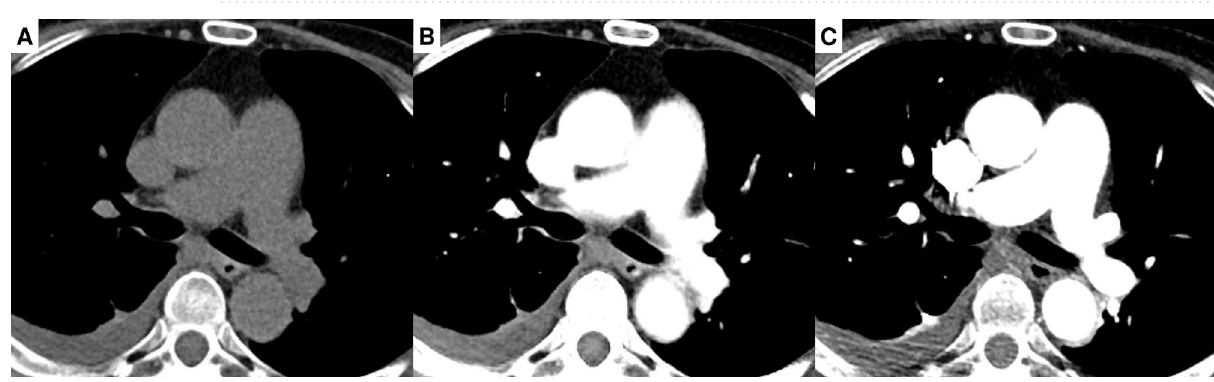
Figure 3. Images of a 65-year-old woman with right pleural effusion from test set 1 are presented. Non-contrast CT ( A ), synthetic contrast-enhanced CT ( B ), and contrast-enhanced CT ( C